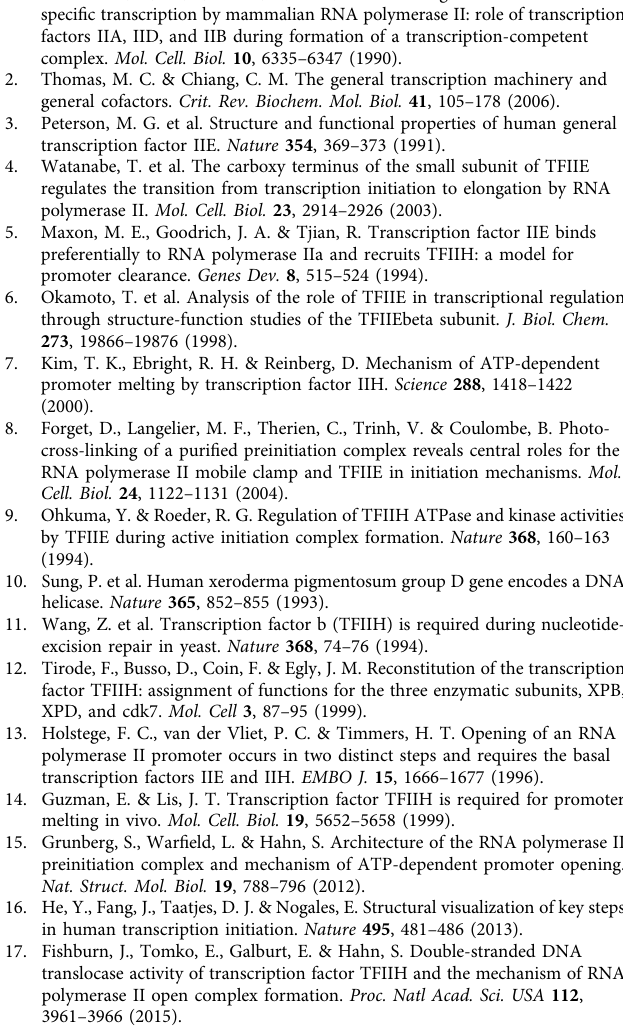
Table 1. PCR (denaturation at 95 °C for 10 s, annealing at 65°C for 15s, elongation at 72 °C for 15 s) was done using the “ FastStart DNA Master SYBR Green ” kit and the LightCycler apparatus (Roche